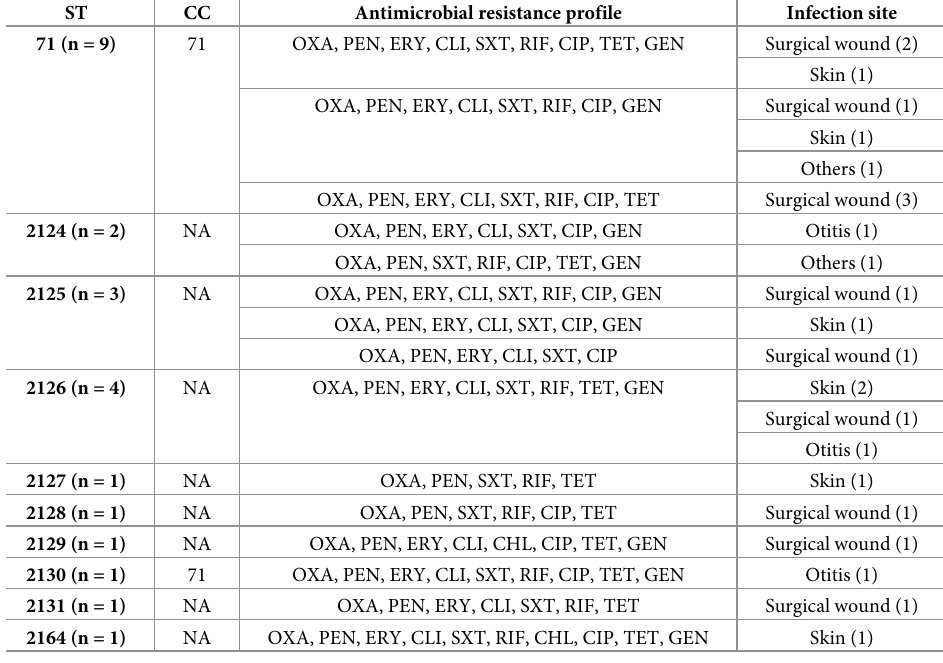
Table 3. Antimicrobial resistance profile of methicillin-resistant S . pseudintermedius (MRSP) strains isolated from dogs (Belo Horizonte, Brazil) according to sequence types (STs) and infection